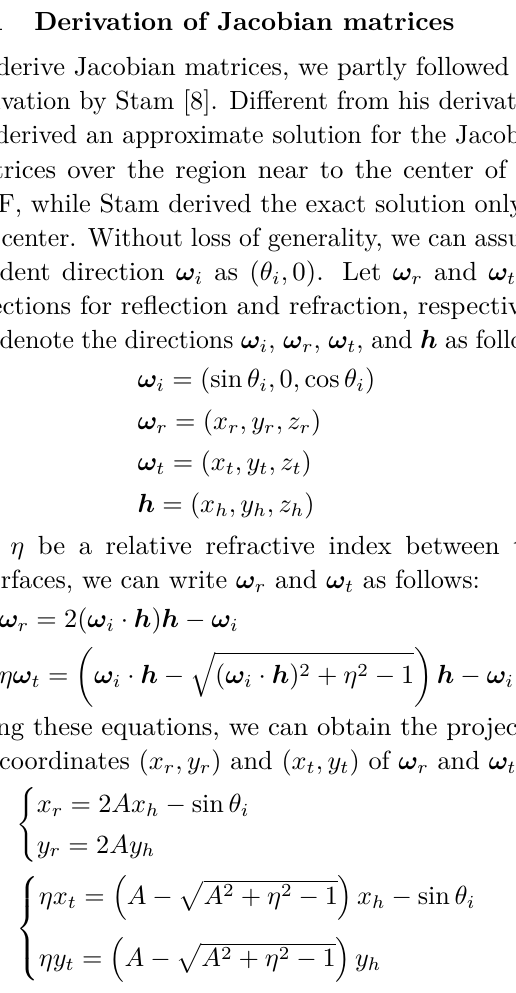
Fig. 7 The visual comparisons with RMSEs are shown to different combination of tangent vector directions. From top to bottom, the tangent vectors of two layers have π/ 2 ,π/ 3, and π/ 6 gaps, respectively.